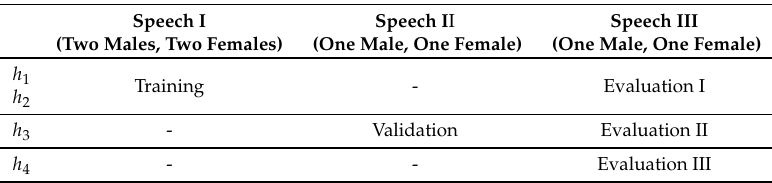
Table 2. Training, validation, and evaluation sets depending on RIRs